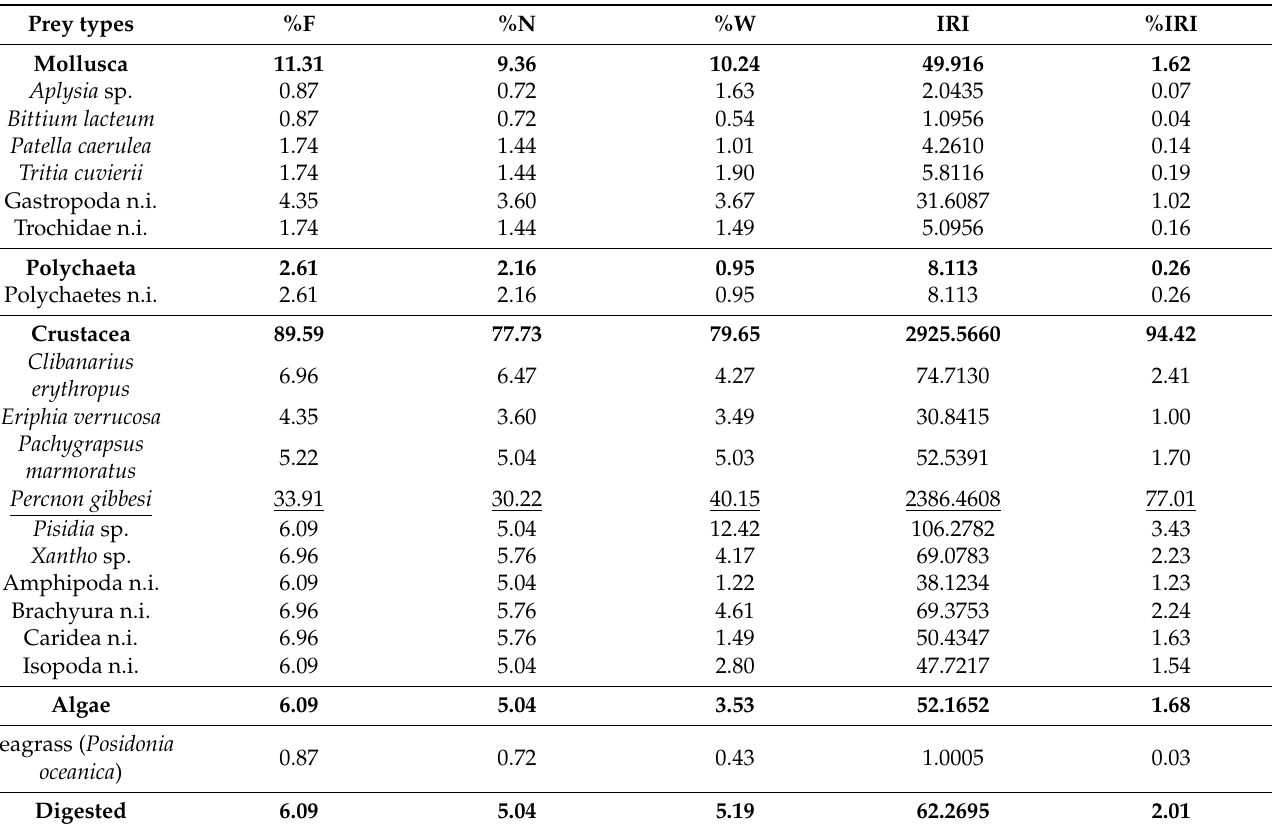
Table 2. Diet composition of G. paganellus (N = 115) from the Ionian Sea (central Mediterranean Sea). %F = percentage frequency of occurrence; %N = percentage in number; %W = percentage in biomass; IRI = index of relative importance of prey items and its percentage (%IRI). Results for Percnon gibbesi are